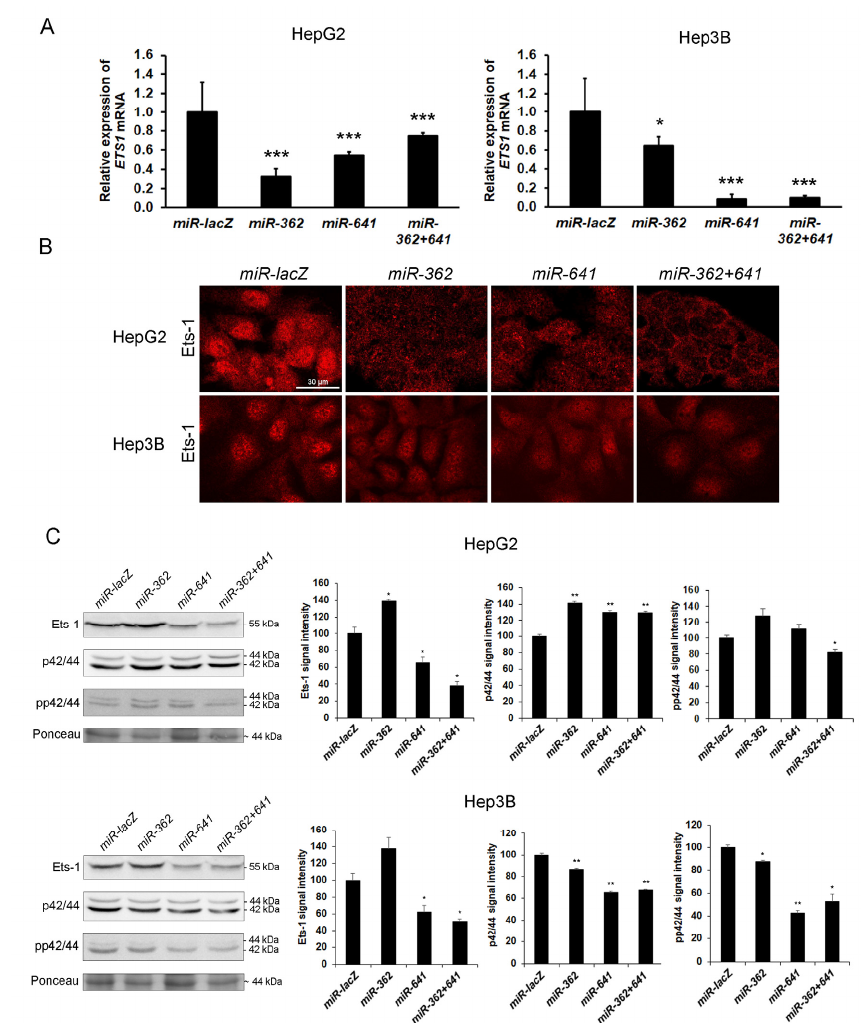
Figure 8. Silencing of Ets-1 by RNA interference in HepG2 and Hep3B cells. ( A ) As indicated by the qRT-PCR results, knockdown of Ets-1 expression was successful in both cell lines; ( B ) The silencing constructs effectively hindered Ets-1 protein expression; ( C ) Except for miR-362 , Western blots confirmed the downregulation of Ets-1; however, inactivation of ERK1/2 was mostly detected in Hep3B cell line. Data points represent the mean ± SD, (A) n = 3, (C) n = 2; * p < 0.05; ** p < 0.01; *** p < 0.001 versus miR-lacZ transfectant. Representative images are at 600× magnification (scale bar 30 μ m).